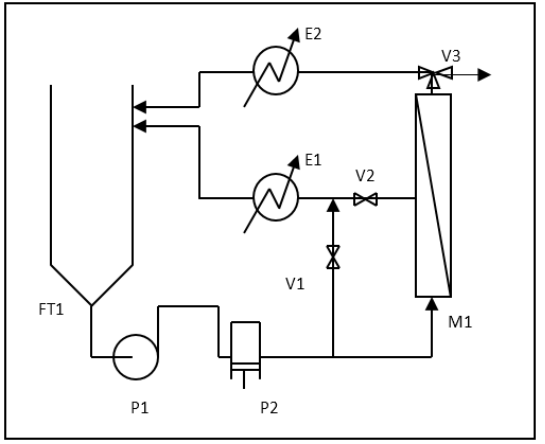
Figure 1. Schematic of the pilot plant. E: heat exchanger; FT: feed tank; M: membrane housing; P: pressure; V: valve. P: pressure; V: